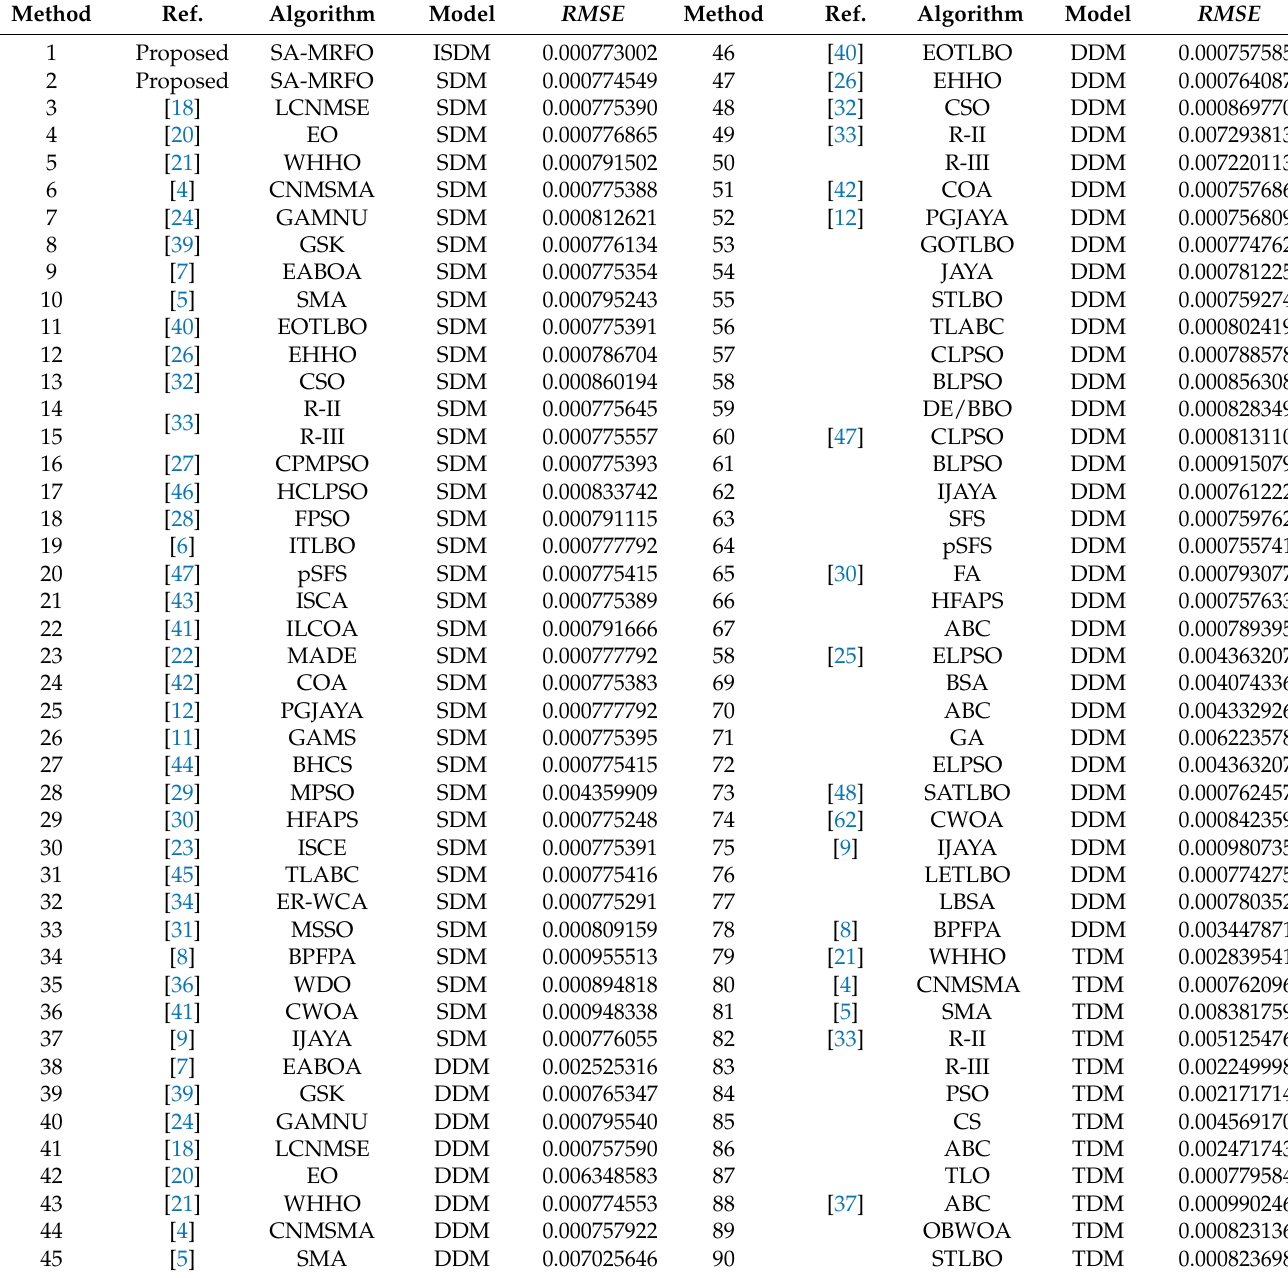
Table 2. RMSE calculation for the solar RTC France cell using various